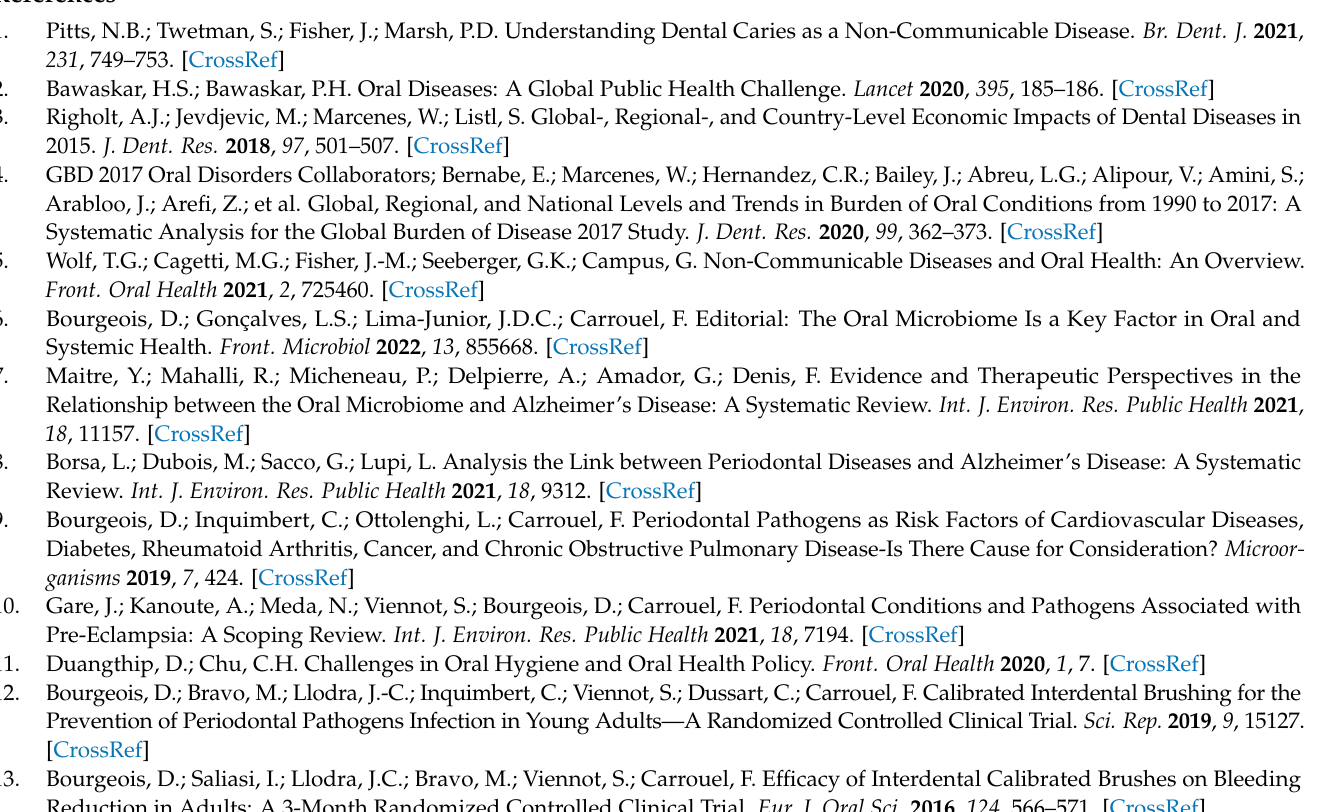
Table S10: Mobile App Rating Scale (MARS) scoring by section; Table S11: Mobile App Rating Scale (MARS) scoring by